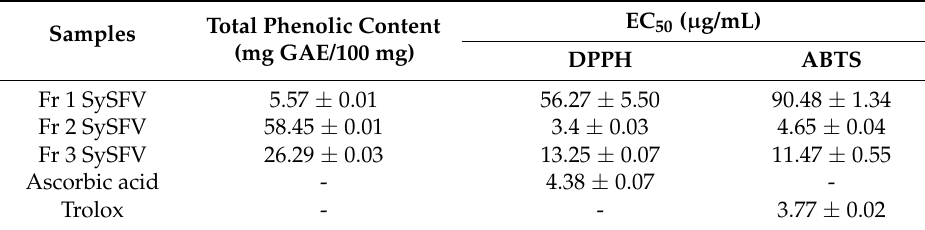
Total phenolic content of the wine fractions (expressed as gallic acid equivalents, GAE/100 mg fraction) and their antioxidant radical scavenging activity (as EC 50 values).